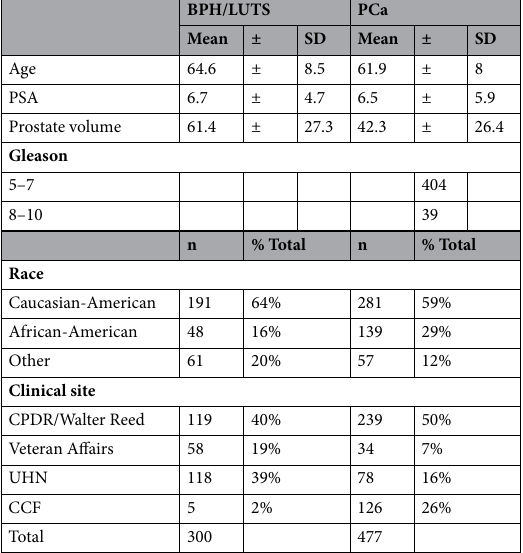
Table 1. Patient demographics of 777 patients evaluated. Age (years), PSA levels (ng/mL), and prostate volume (mL) (Mean ± standard deviation, SD). Distribution of patients by race and sampling distribution of patients from various clinical